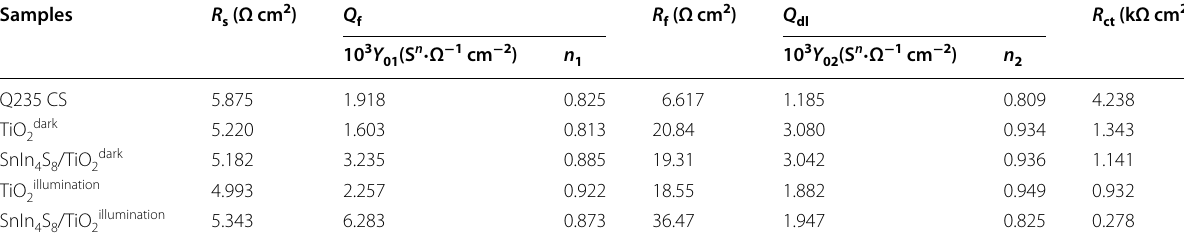
of the impedance arc of the coupled Q235 CS electrode under visible light was smaller than that of pure Q235 CS, and the R ct values of the coupled Q235 CS electrode decreased significantly. The results indicate that the rate of the electrochemical reaction at the interface between the Q235 CS and the solution increased remarkably, which may be due to the migration of photoelectrons from the photoanode to the Q235 CS [60]. In addition, the R ct value of the SnIn 4 S 8 /TiO 2 composite was smaller than that of TiO 2 , which may be because the hetero- junction formed by TiO 2 and SnIn 4 S 8 was conducive to the separation and migration of photoinduced charges. These results were consistent with those obtained from the Tafel curves (Fig. 9). Furthermore, the diameter of the impedance arc of the SnIn 4 S 8 /TiO 2 composite under visible light was distinctly smaller than the impedance after the light was turned off, suggesting that more pho- toelectrons migrated from the SnIn 4 S 8 /TiO 2 composite Table 2 Fitting impedance parameters of Nyquist plots using the equivalent circuit in Fig. 10b